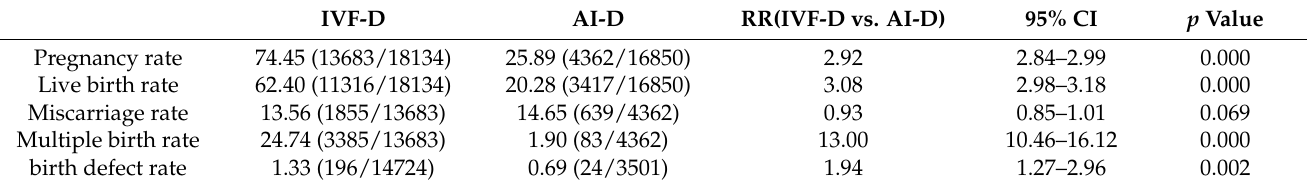
Table 1. Clinical outcomes of IVF-D and AI-D during 2014–2019. IVF-D